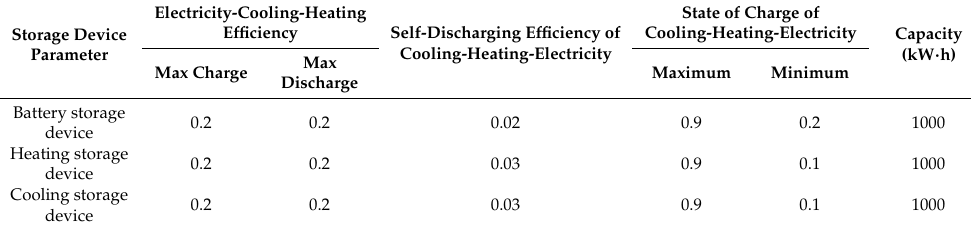
Table 3. Parameters of electricity–cooling–heating storage device.